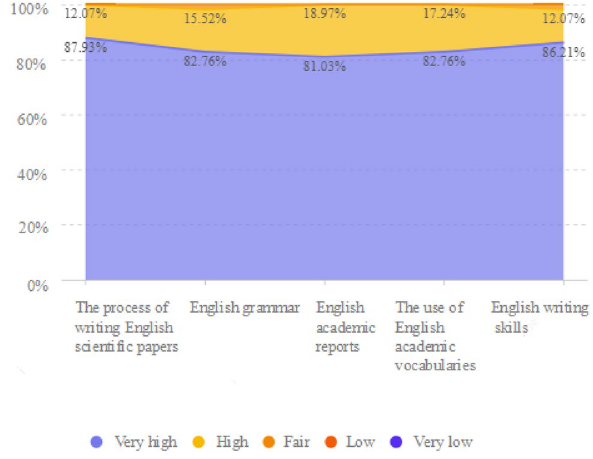
Fig. 4 Improvement of academic English